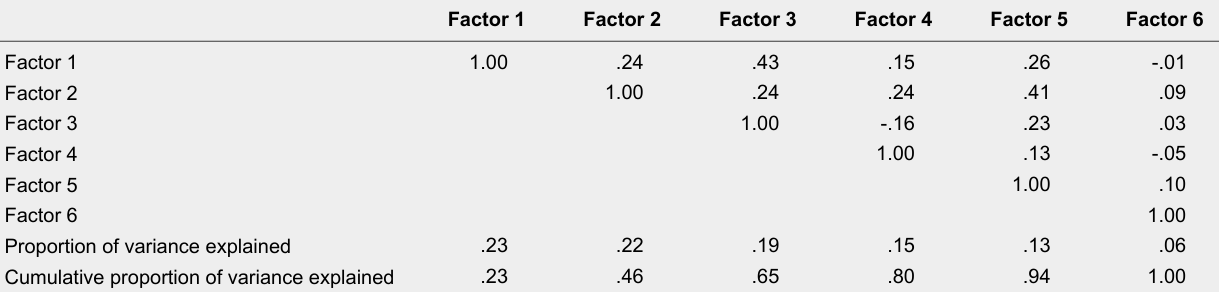
Summary of the Factor Correlations and Variance Explained in the Exploratory